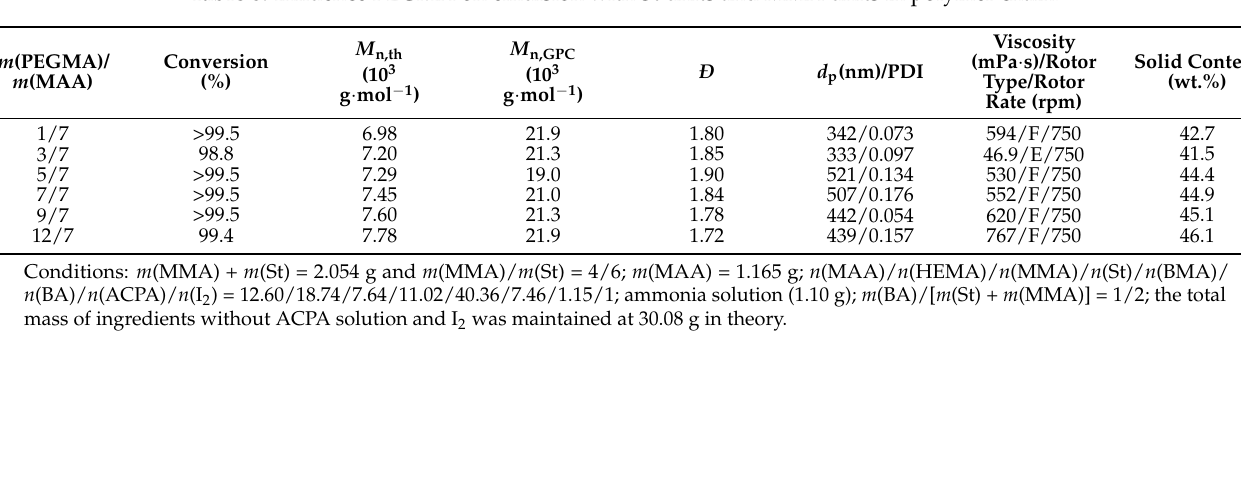
Table 8. Influence PEGMA on emulsion with St units and MMA units in polymer